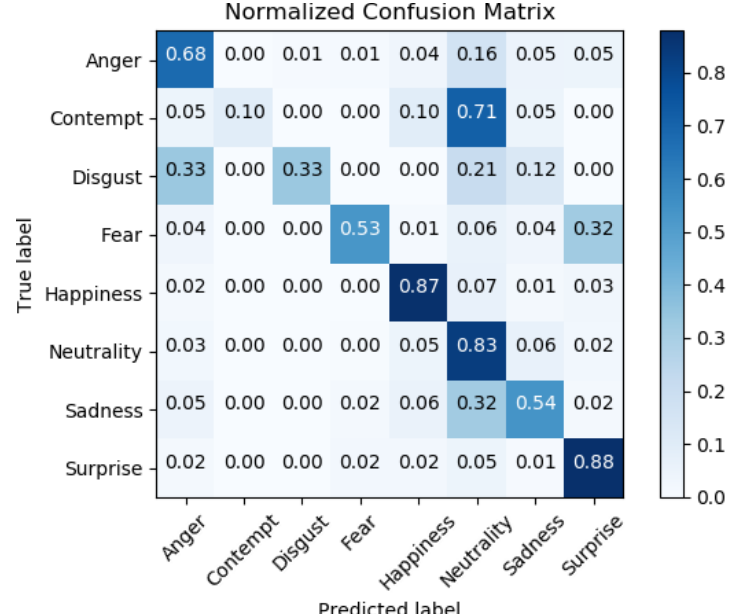
Figure 6. Normalized confusion matrix of the network in [21], trained with the FER2013 database with the FER+ annotations using the data augmentation and the z-score normalization. Figure from [35].